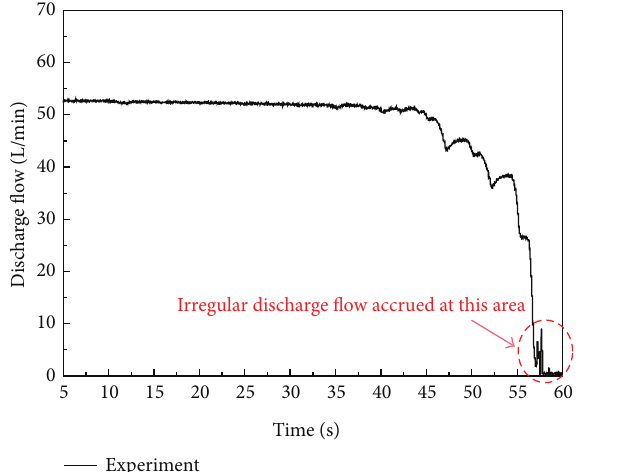
Figure 7: An irregular discharge flow characteristic at the cut-off pressure area of developed VDAPP in experiment.